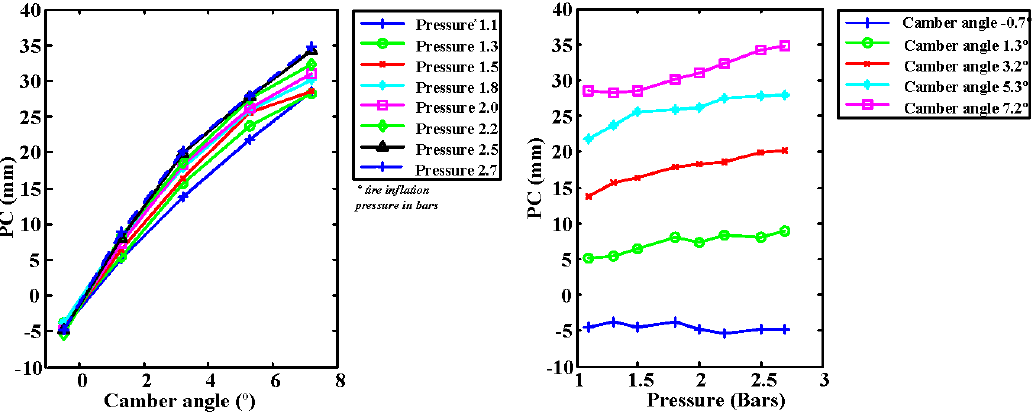
Figure 16. Pressure center (PC): vs. camber angle ( left ); and vs. tire inflation pressure ( right ).